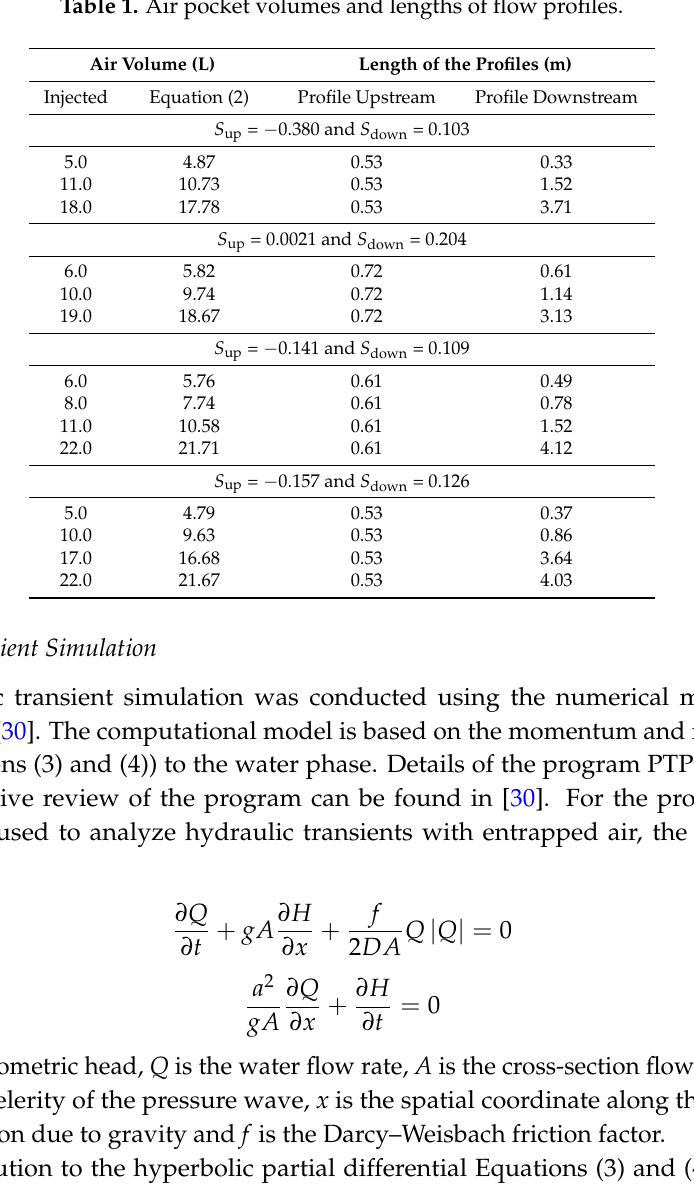
Table 1. Air pocket volumes and lengths of flow